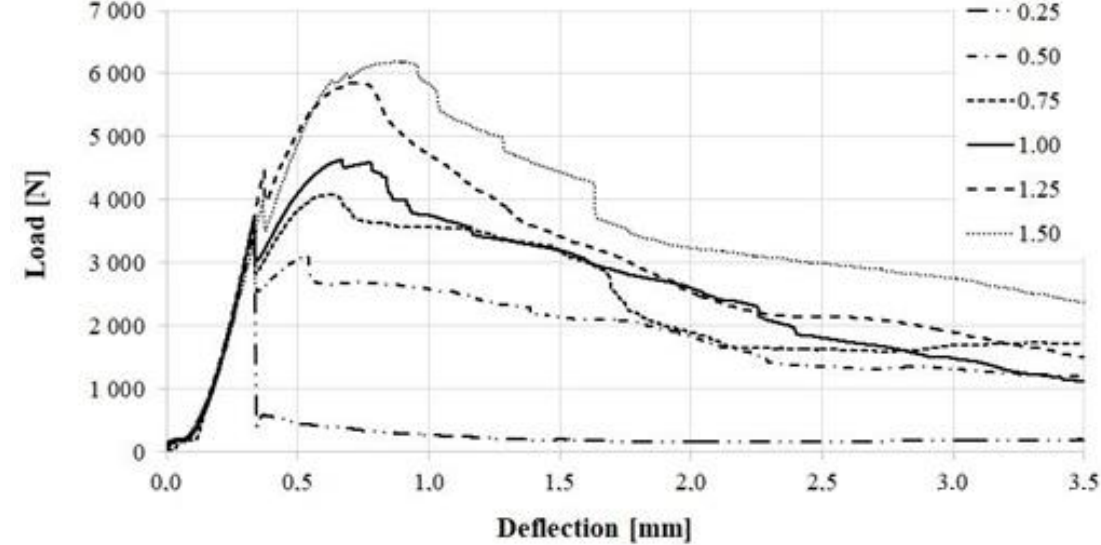
Figure 10. Load-deflection curve for specimens with steel cord.